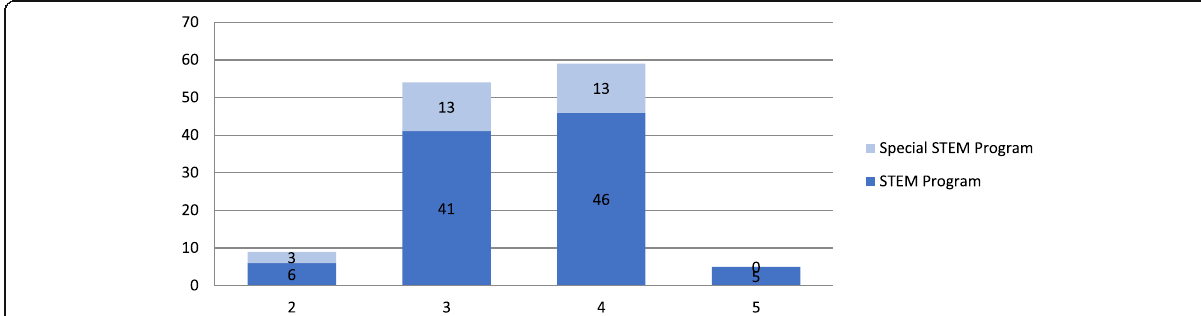
Fig. 7 The number of projects in terms of years of project duration. (Note, 2: 2-year projects; 3: 3-year projects; 4: 4-year projects; 5: